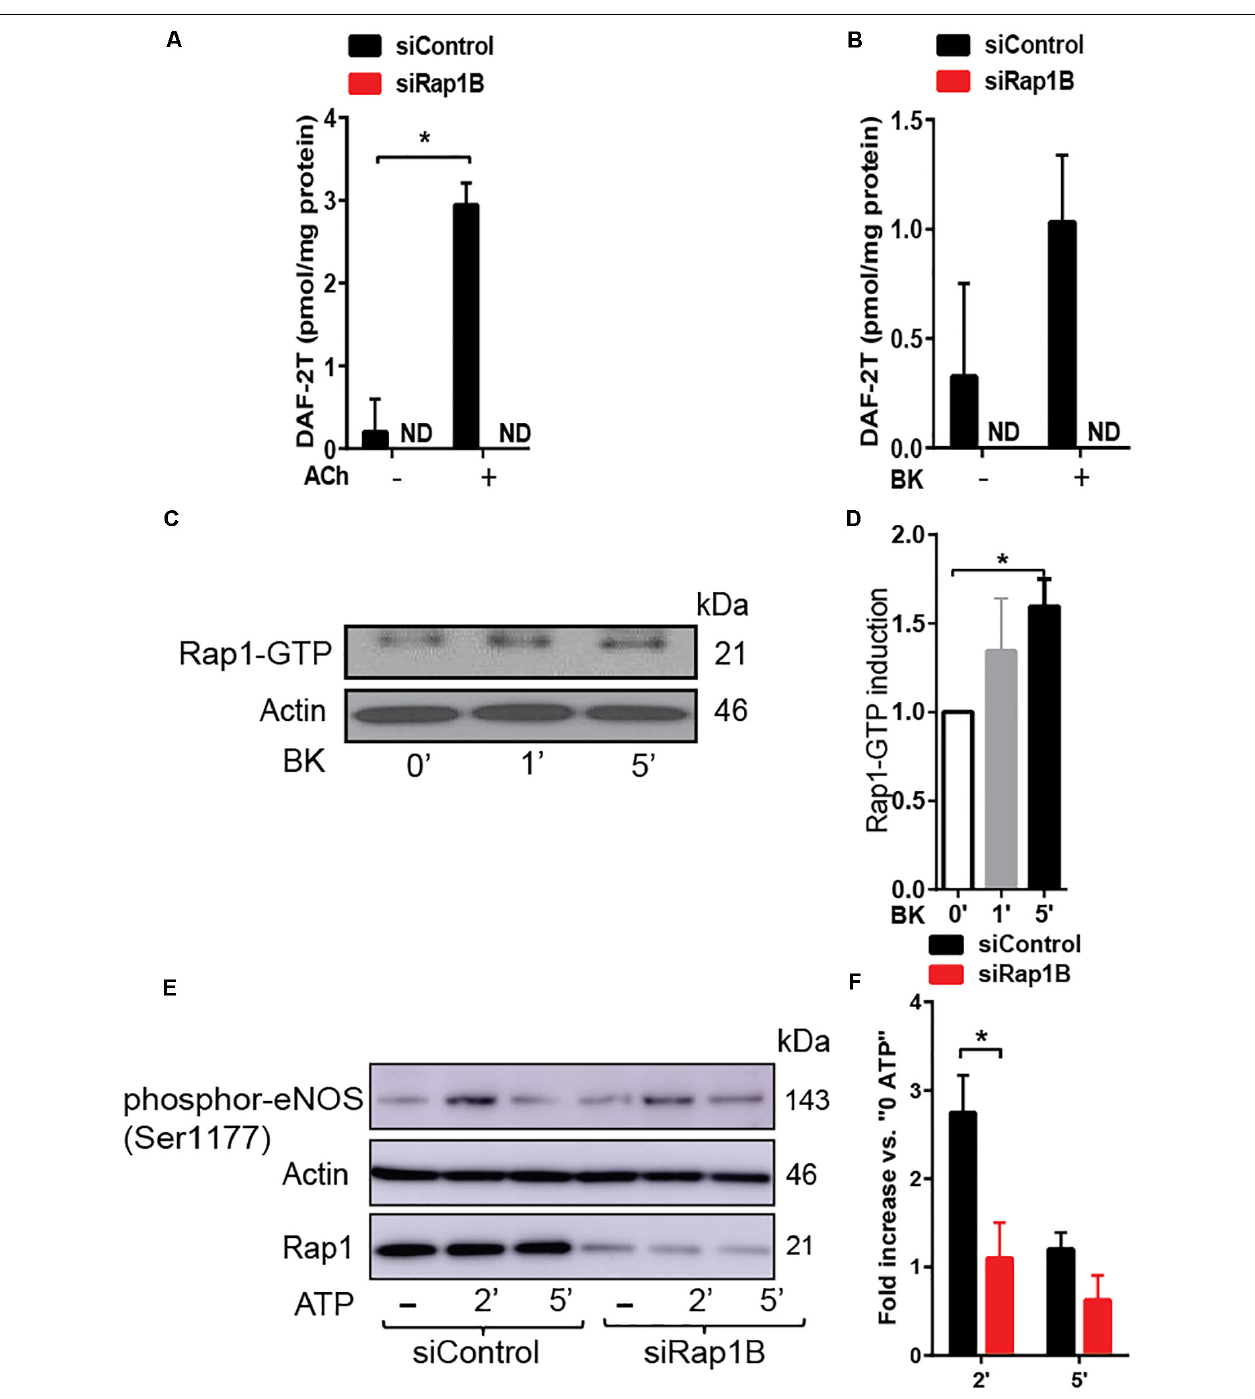
FIGURE 2 | (A,B) RaplB deletion inhibits agonist-induced NO release. NO release measured in HPAECs preincubated with 2 ml DAF-DA (5 µ M) + L-arginine 10 µ M with or without ACh (A) and bradykinin (BK) (B) for 30 min at 37 ◦ C. Mean values of concentrations calculated using authentic standards are shown ( n = 3). ND: not dected. * indicates p < 0.05 vs. siControl unstimulated. One-way ANOVA Tukey’s multiple comparison test was applied to compare statistical significance. (C,D) Rap1 is activated by GPCR agonist that induced nitric oxide (NO). Bradykinin (BK)-induced, GTP-bound Rap1 using Rap1-GTP pulldown assay. Representative immunoblot (C) and quantification (D) of Rap1 bound to GST-RalGDS beads following 1 and 5 min treatment with BK. Values are means ± SEM ( n = 3). * indicates p < 0.05 vs. 0’ BK. Unpaired t -test was applied to compare statistical significance. (E,F) Rap1B deletion attenuates agonist-induced Ser-1177 eNOS phosphorylation. Representative immunoblot (E) and quantification (F) of fold increase of phosphor-eNOS (Ser1177) vs.0 ATP in siControl and siRap1B HCAECs ( n = 4). * indicates p < 0.05 vs. siControl 2’ ATP. One-way ANOVA Tukey’s multiple comparison test was applied to compare statistical significance.